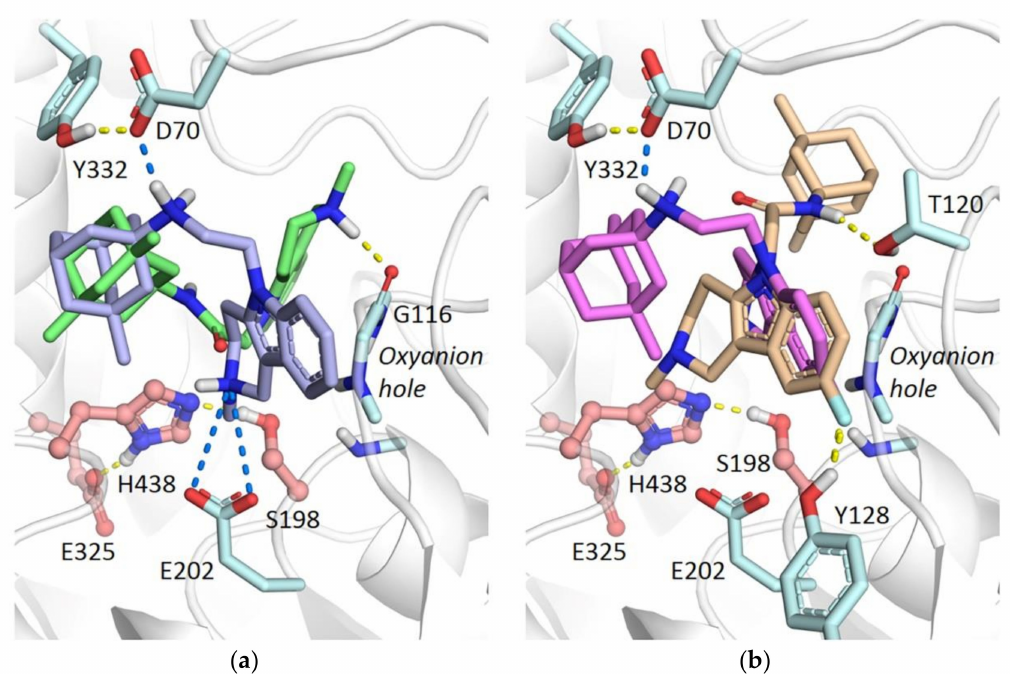
Figure 3. Docking of conjugates linked via ethylene and 1-oxoethylene spacers to BChE: ( a ), comparison of 4a , the ethylene spacer (carbon atoms are shown in light blue) and 8a the 1-oxoethylene spacer (light green); ( b ), comparison of 4c , the ethylene spacer (purple) and 8c , the 1-oxoethylene spacer (sandy